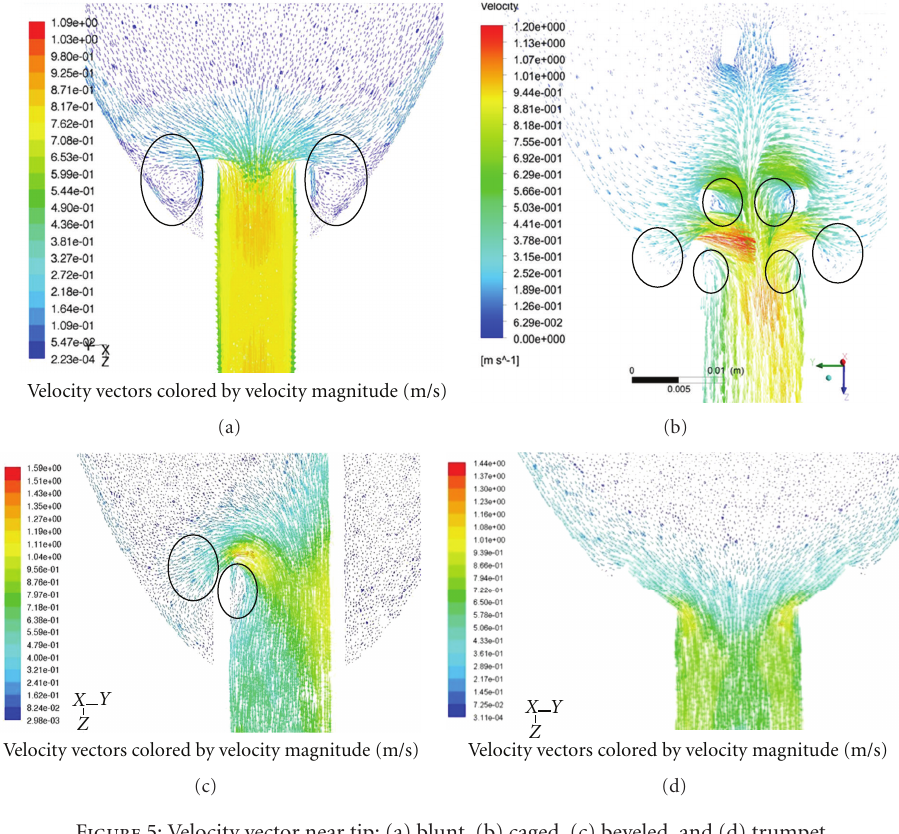
Figure 5: Velocity vector near tip: (a) blunt, (b) caged, (c) beveled, and (d)